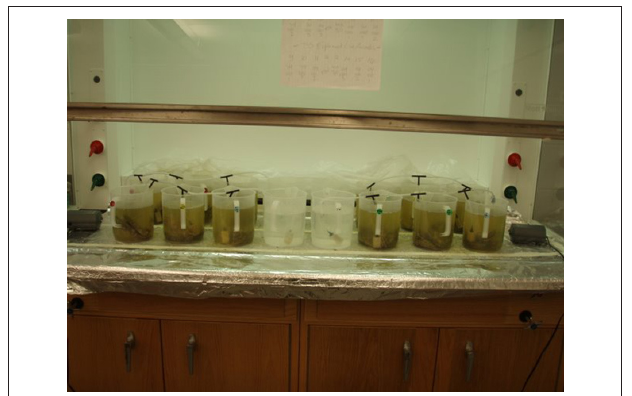
FIGURE 7 | Laboratory experiment for nitrate, salinity, and total suspended solids treatment on oyster quality (Fay, 2009).